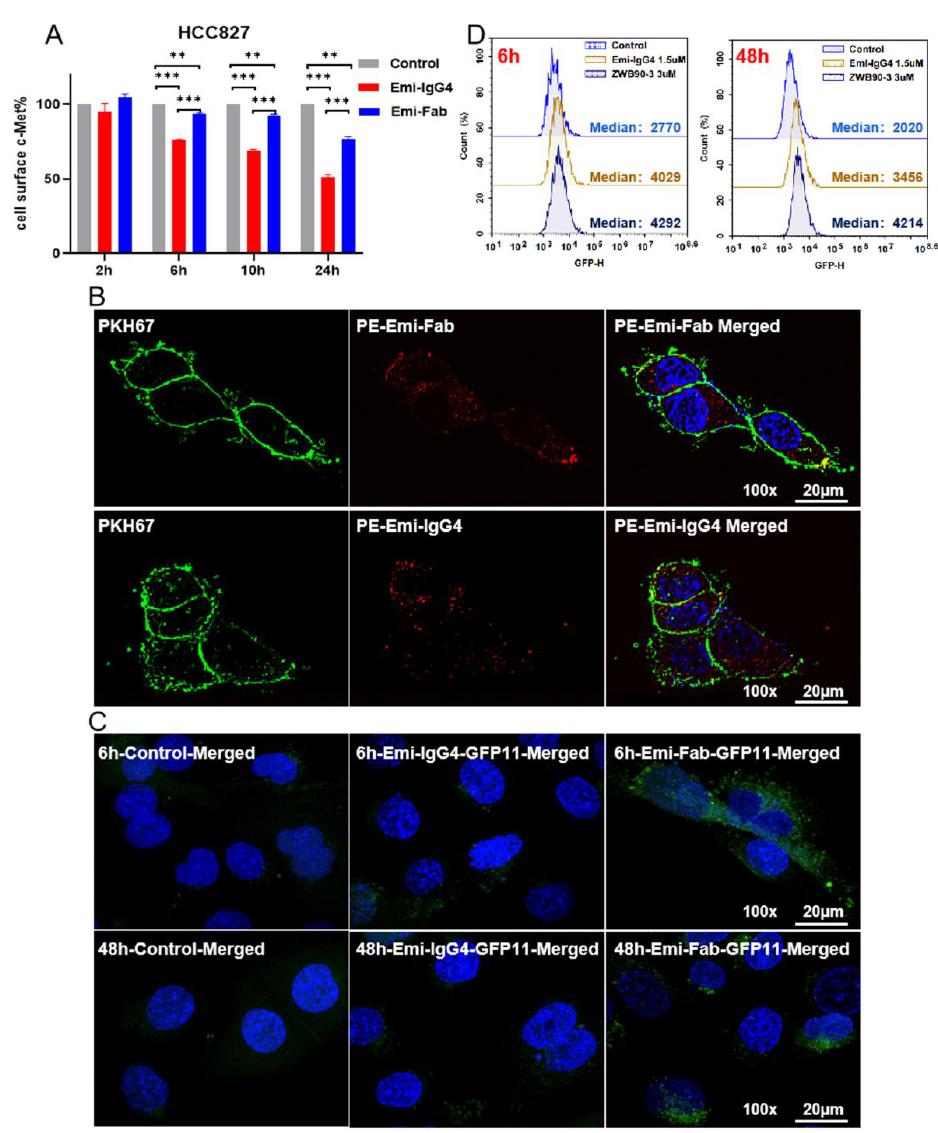
Figure 1. Function, internalization, and endosome-escaping ability of Emi-Fab. ( A ) Effects of Emi-Fab and Emi-IgG4 on c-MET degradation. Results are shown as the mean ± SD and are pooled from two independent experiments. ** p < 0.01 and *** p < 0.001. ( B ) Internalization of Emi-IgG4 and Emi-Fab at equal molar concentrations. Images were acquired at 100 × magnification. Scale bars: 20 µ m. ( C ) Representative microscopy images of cytosolic fluorescence distribution in HCC827-GFP1-10 cells treated with Emi-IgG4-GFP11 (250 nM) or Emi-Fab (500 nM) for 6 h and 48 h, respectively, as indicated. ( D ) Histograms of GFP β 1-10 expressing HCC827 cells treated with Emi-Fab-GFP β 11 or Emi-IgG4-GFP β 11 as measured by flow